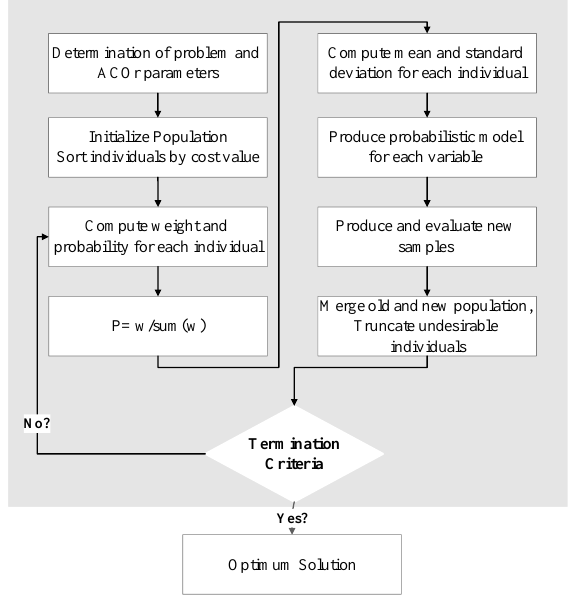
Figure 3. General Flowchart of ACO